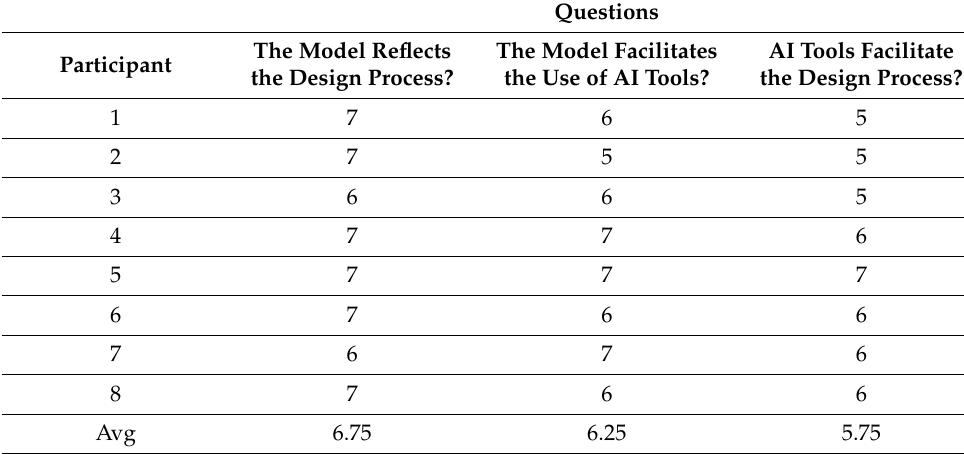
Table 6. Perception of the participants regarding the use of the proposed model. Questions The Model Reflects The Model Facilitates AI Tools Facilitate Participant the Design Process? the Use of AI Tools? the Design